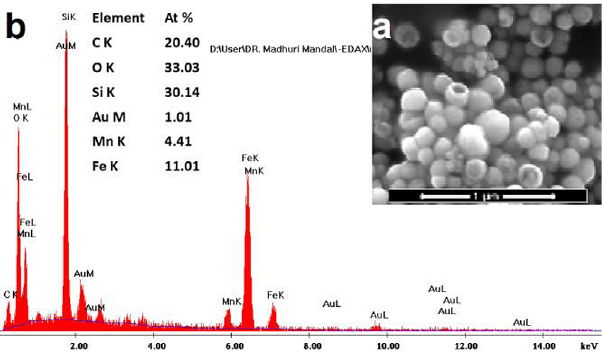
Fig. 2. (a) FESEM image of HMF NPs and (b) EDAX spectra with elemental analysis (inset) during FESEM